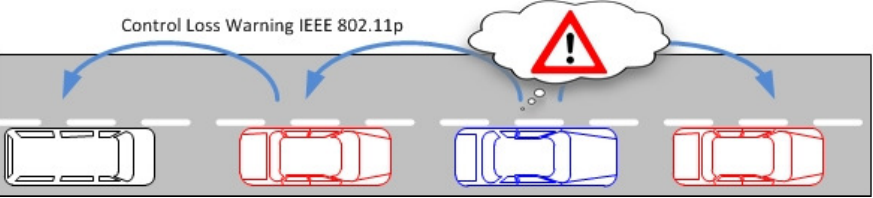
Figure 3. Vehicle control loss